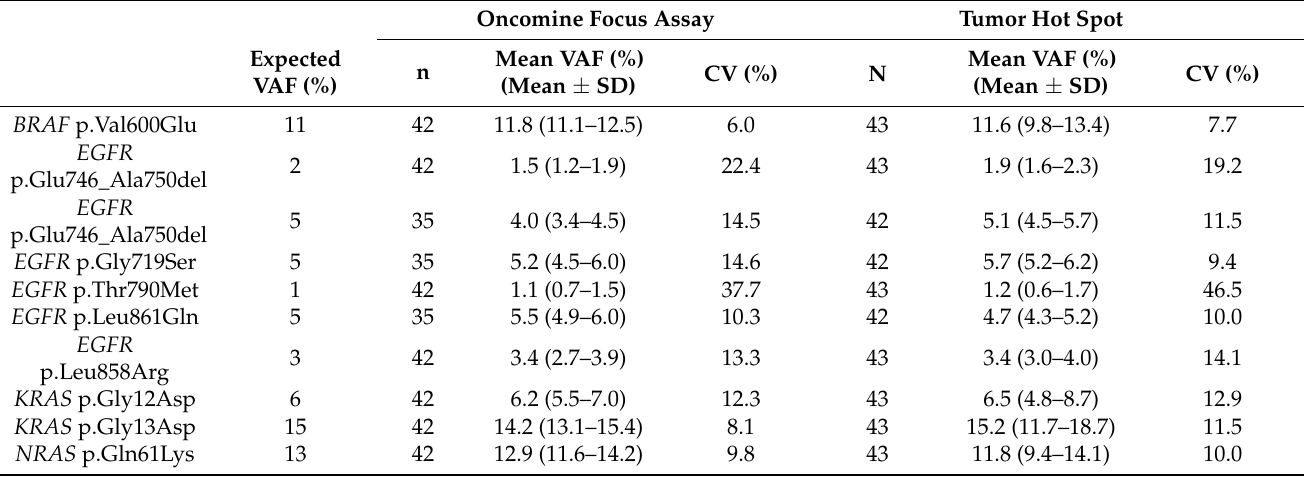
Table 1. Inter-run variability of VAF obtained with HD200 and HD300 QC materials on S5XL and MiSeq